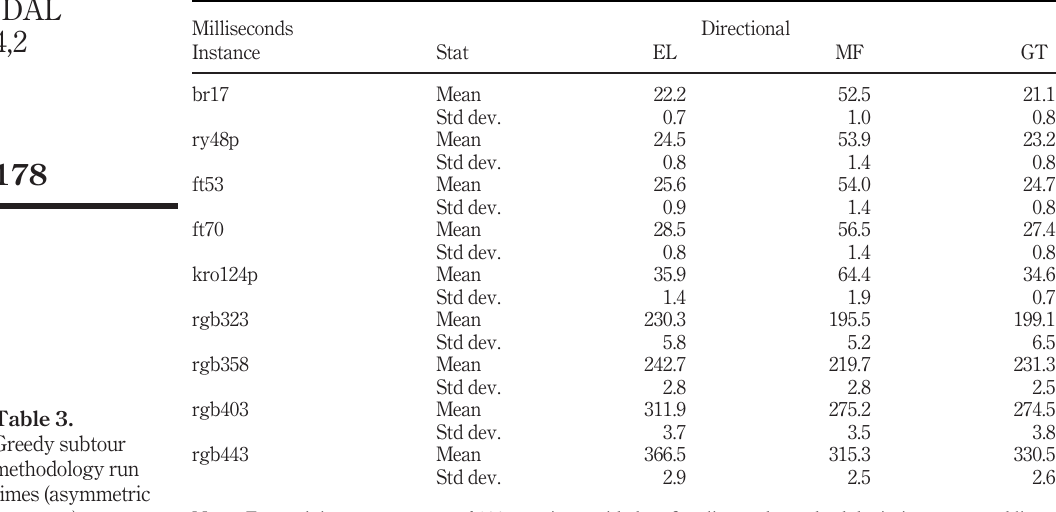
Table 3. Greedy subtour methodology run times (asymmetric